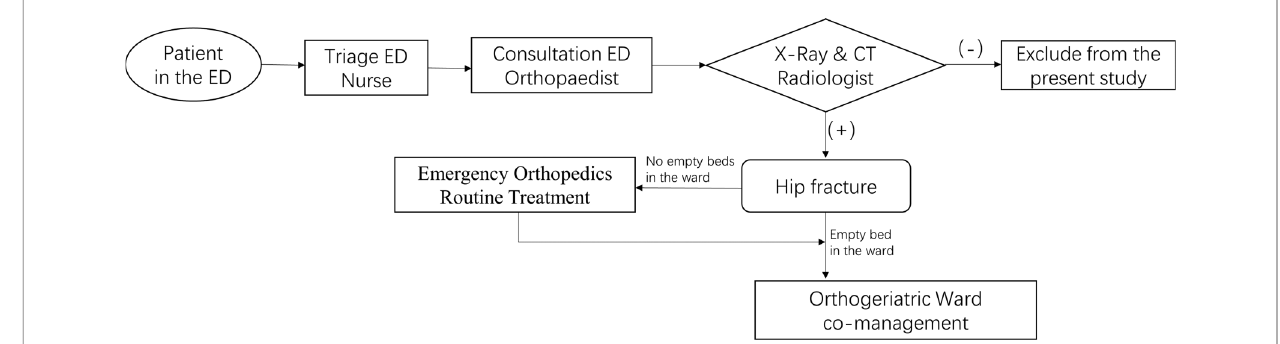
FIGURE 1 | Flow chart of operation mode of control